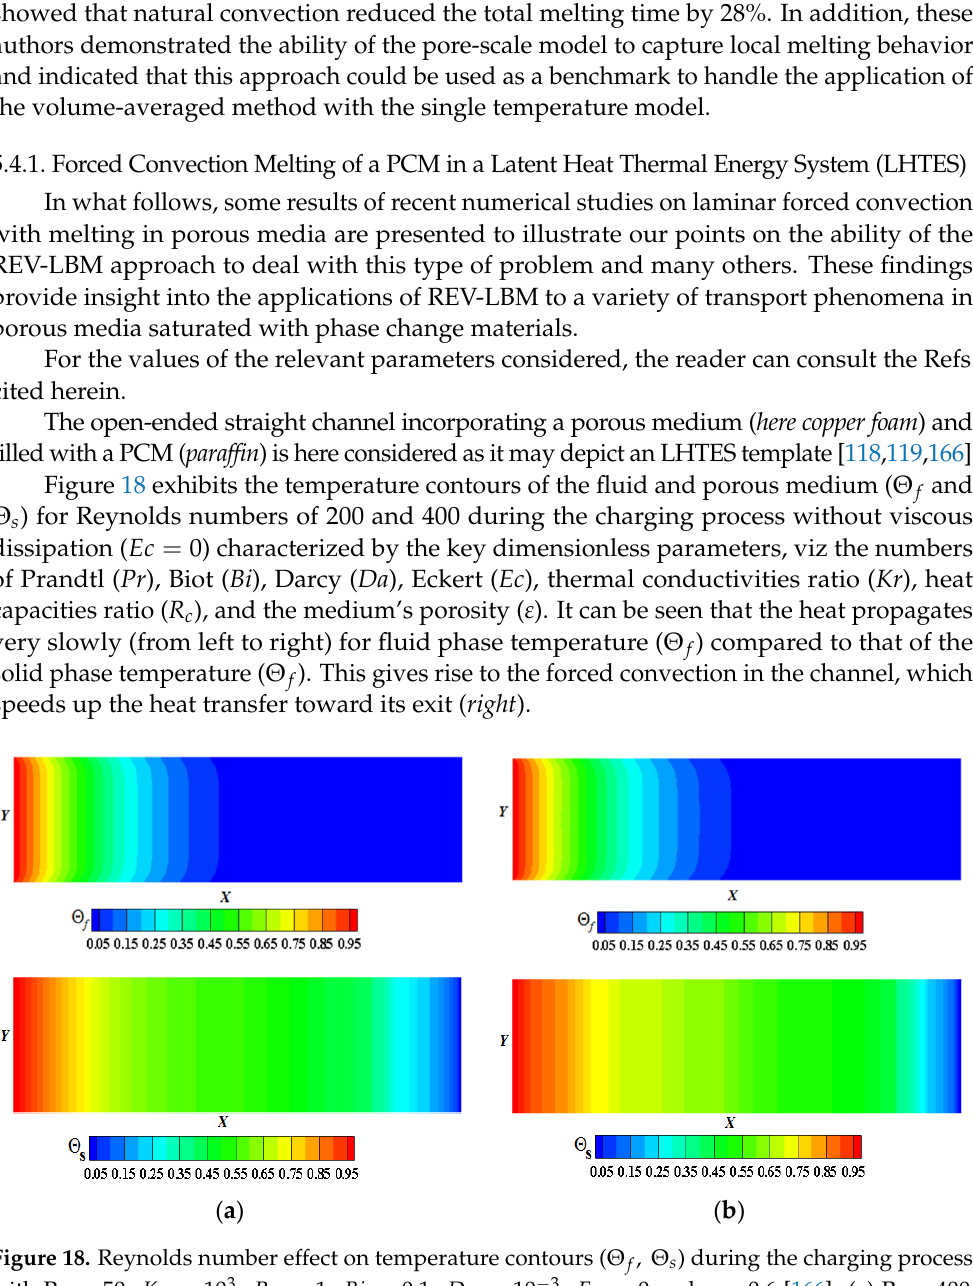
t = 7333 s Figure 19. Porosity effects on melt front ( Γ ) vs. time during charging process for Re = 400 with 3 50 [118].